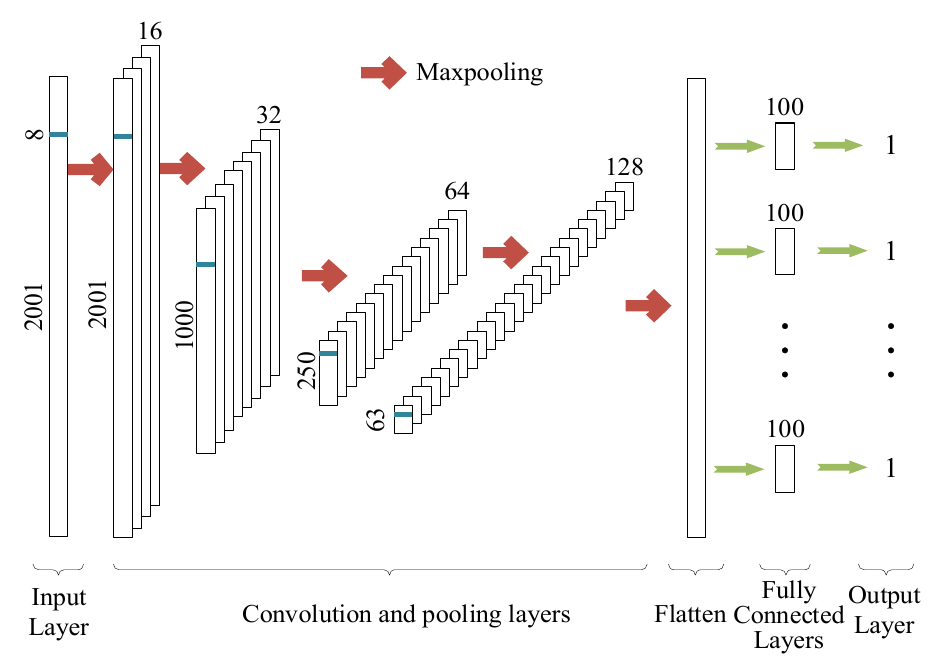
Figure 2. Convolutional Neural Network (CNN) architecture.